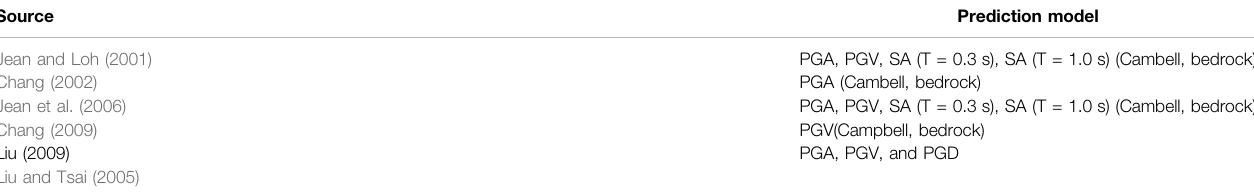
TABLE 3 | Ground motion prediction models.